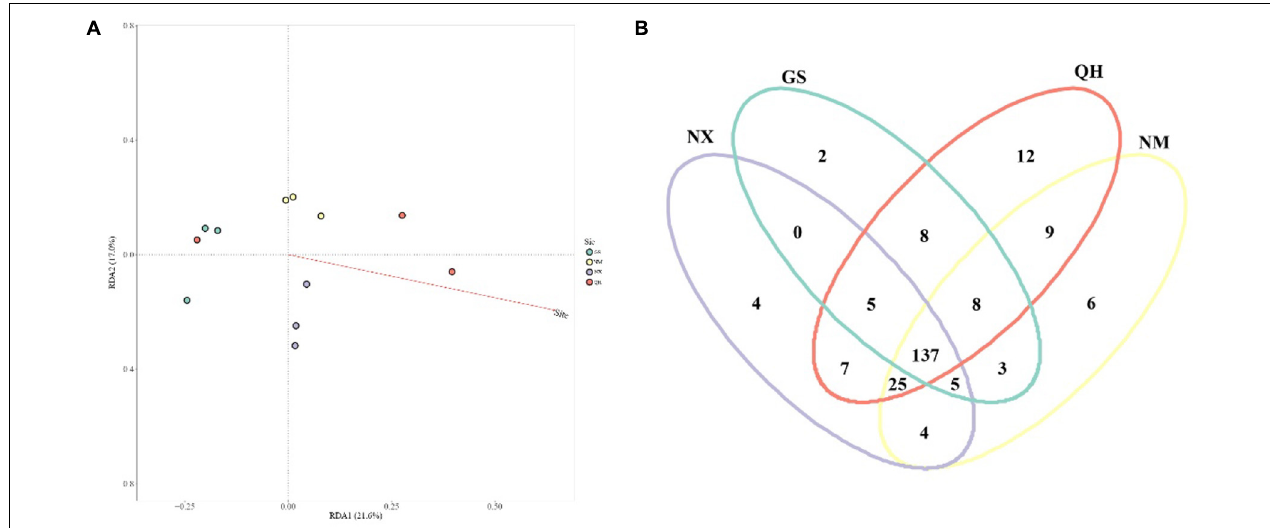
FIGURE 4 | (A) Redundancy analysis (RDA) plot of ECM fungal community and environmental variables among four sites at the species level. The percentage of the X -axis and Y -axis represents the proportion of explained variance. (B) Venn diagram illustrating the number of unique and shared operational taxonomic units.